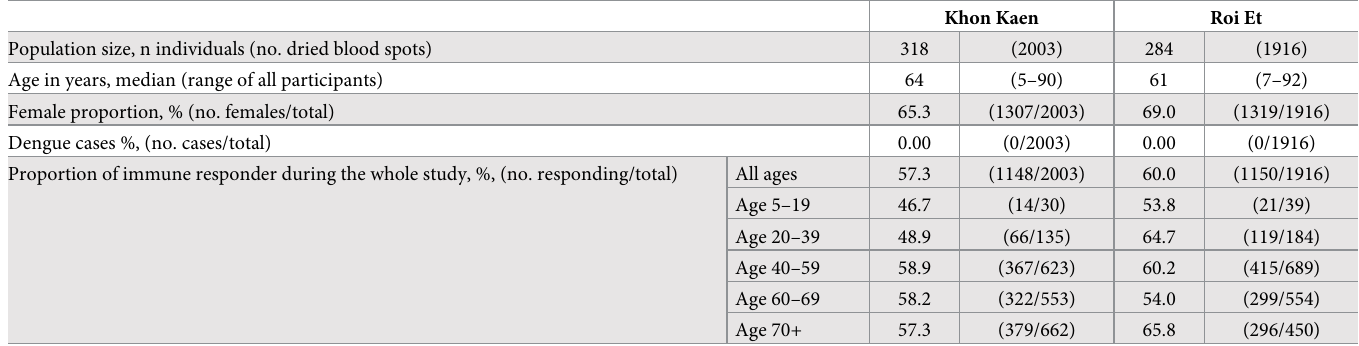
Table 1. Population description and immunological status to Nterm-34 kDa salivary peptide. Population size, n individuals (no. dried blood spots) Age in years, median (range of all participants) Female proportion, % (no.